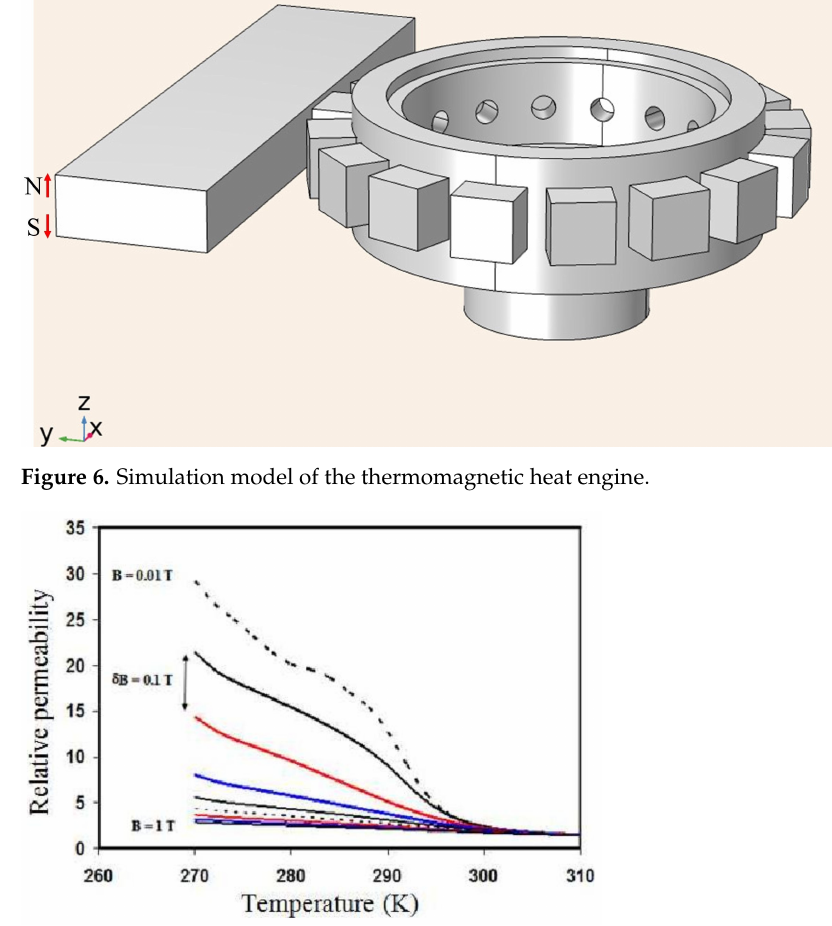
Figure 7. Relationship between the temperature and relative permeability of gadolinium.